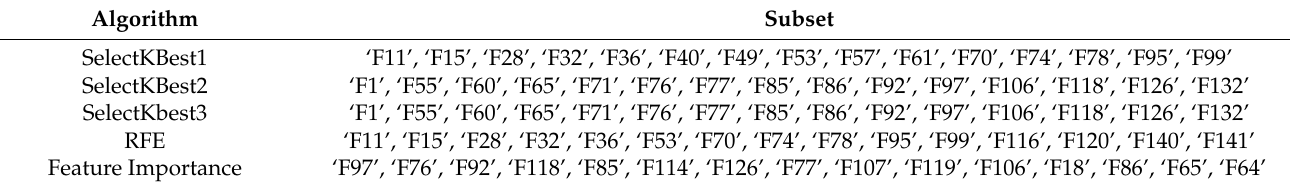
Table 5. Subsets of features selected by single